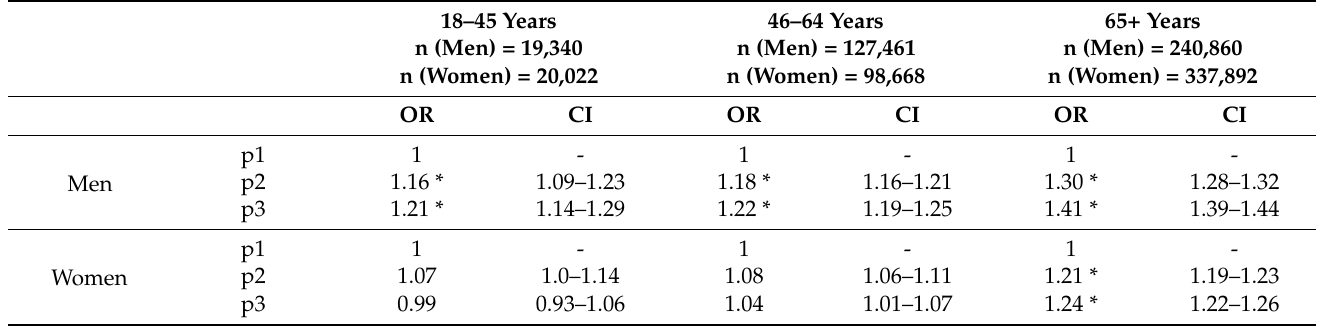
Table 2. Odds ratios and confidence intervals of the effect of time on the number of medications in individuals with T2D, stratified by age and gender, estimated by means of ordered logistic regression. Adjusted for age (within each age group) and insurance